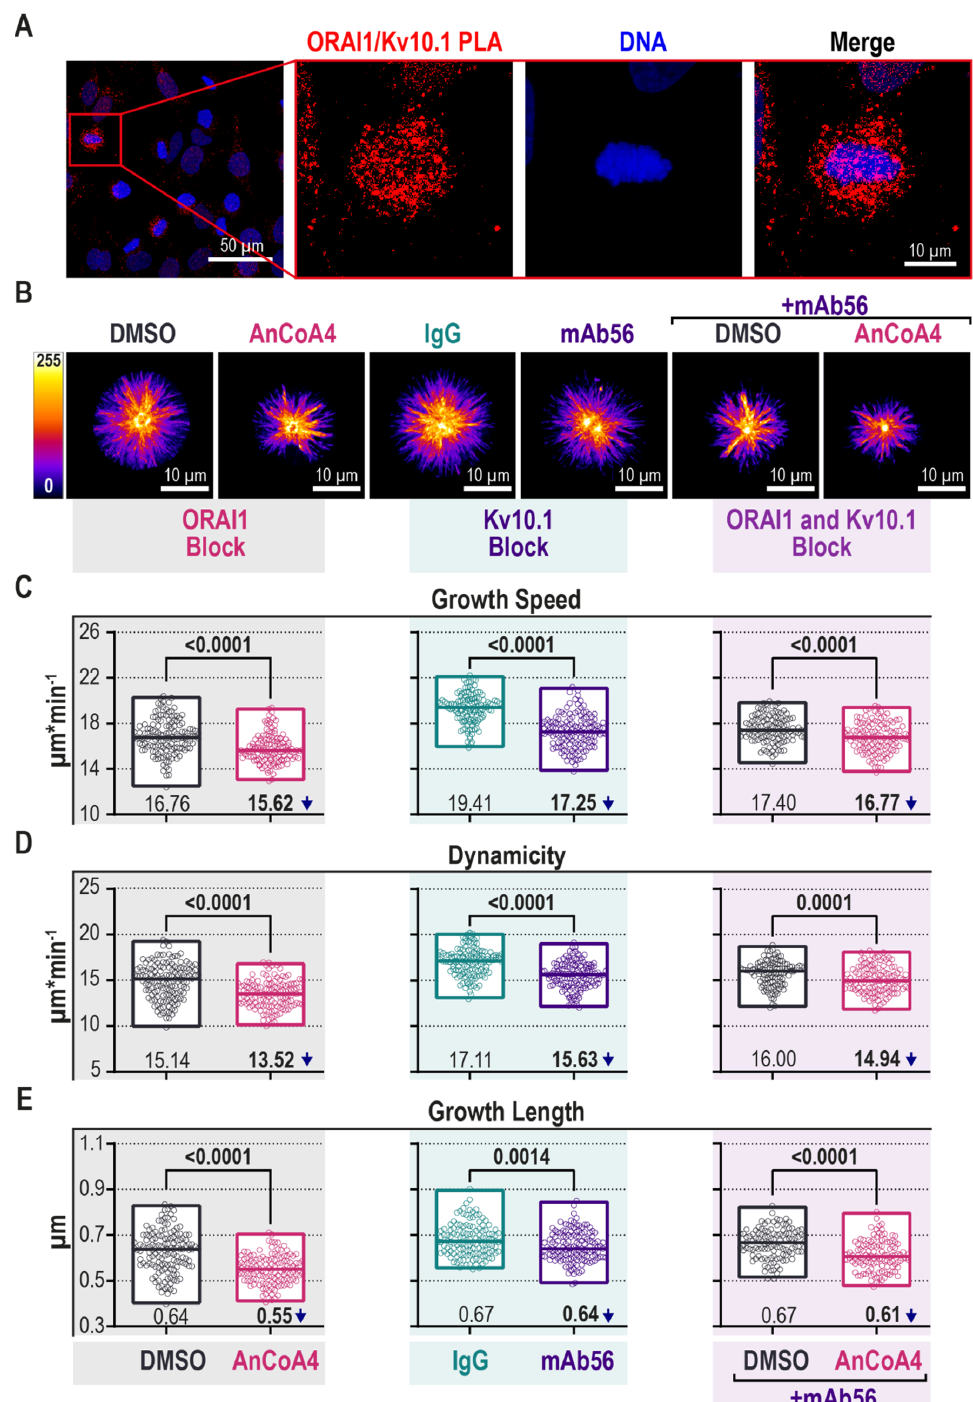
Figure 4. A block of either Kv10.1 or ORAI1 currents reduces MT dynamics in HeLa cells. ( A ) Example images of Kv10.1 and ORAI1 proximity ligation assay (red foci) in asynchronous HeLa cells (scale bar, 50 µm) and a mitotic cell (zoomed-in inset: scale bar, 10 µm; nuclei—blue) are given. ( B – E ; Videos S5–S10) HeLa cells, transiently expressing pEB3-tdTomato were treated as follows: left grey panel—4h with the ORAI1 blocker AnCoA4 (10 µM) or empty vehicle (DMSO); middle green panel—24 h with the Kv10.1 blocker mAb56 or control IgG κ2b (both 5 µg/µL); right purple panel—a combination of both treatments. In all cases, the last 4 h of the treatments, the cells were exposed to 2.5 µ M DME. Microtubule